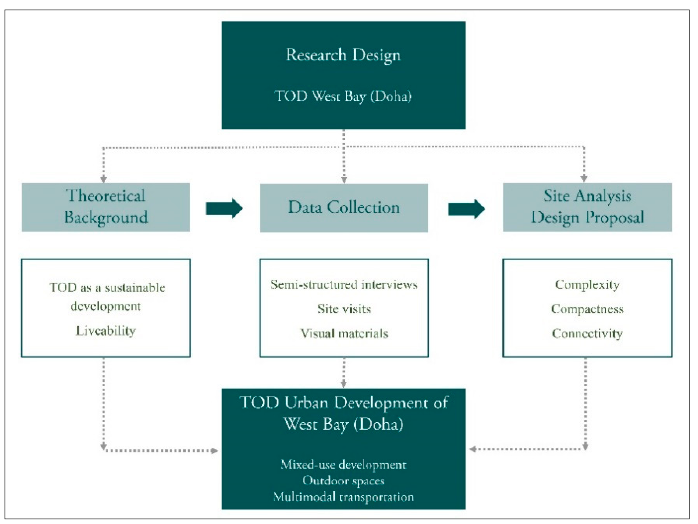
Figure 5. Structure of the research project’s framework (Source: the Authors).